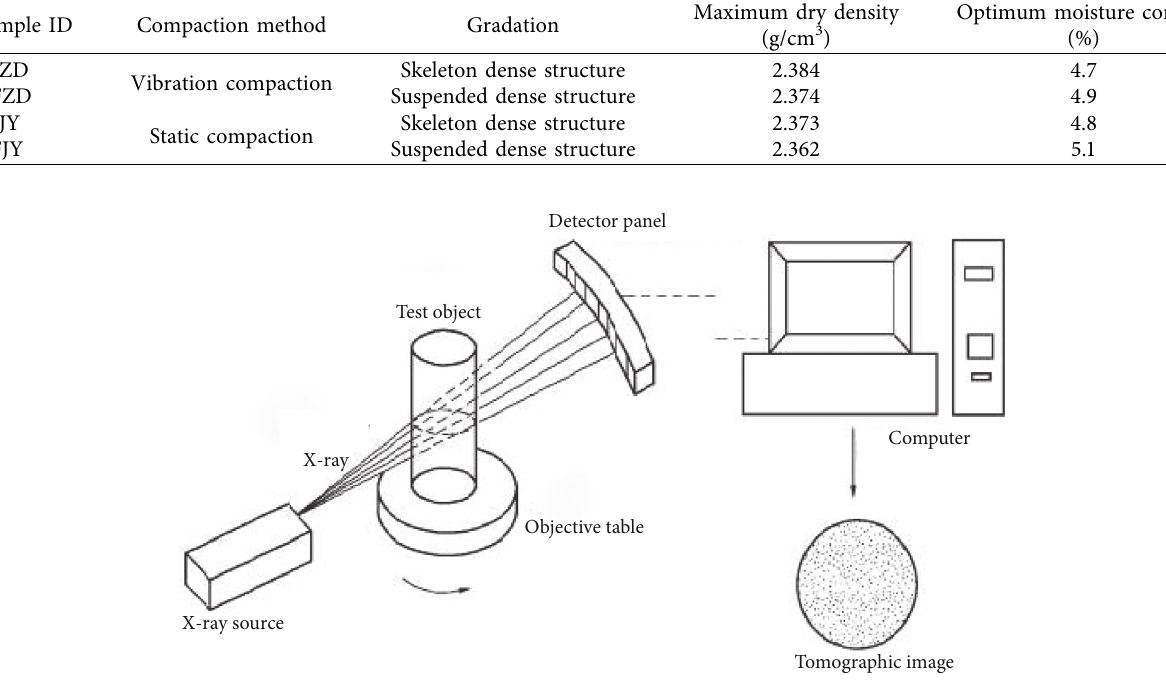
Figure 1: CT imaging schematic diagram.